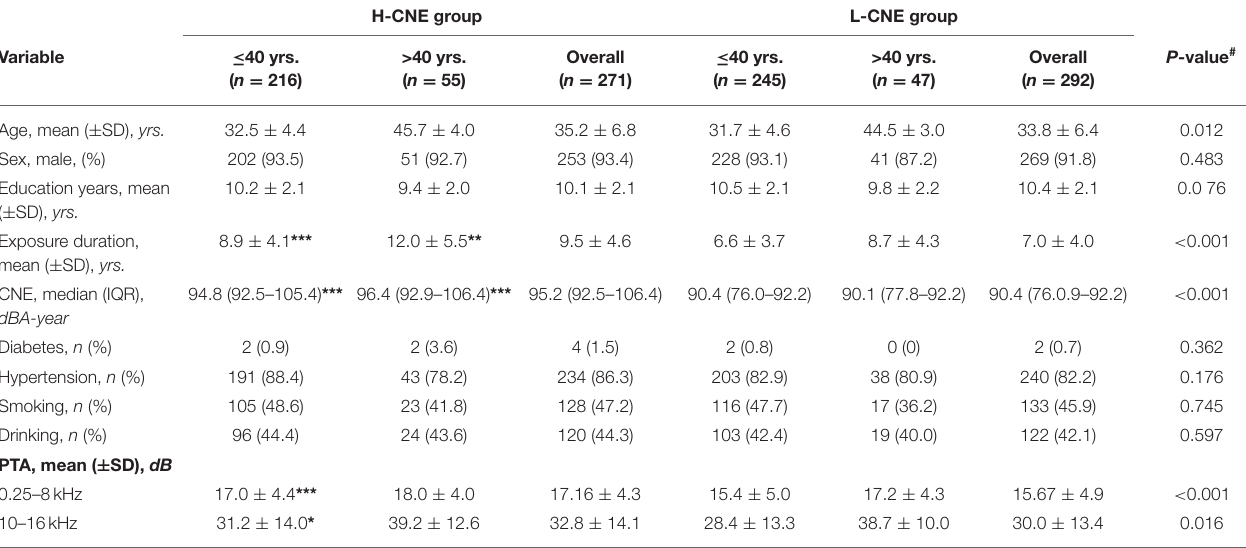
TABLE 1 | Demographic characteristics of subjects in the high-cumulative noise exposure (H-CNE) and low-CNE (L-CNE) groups.